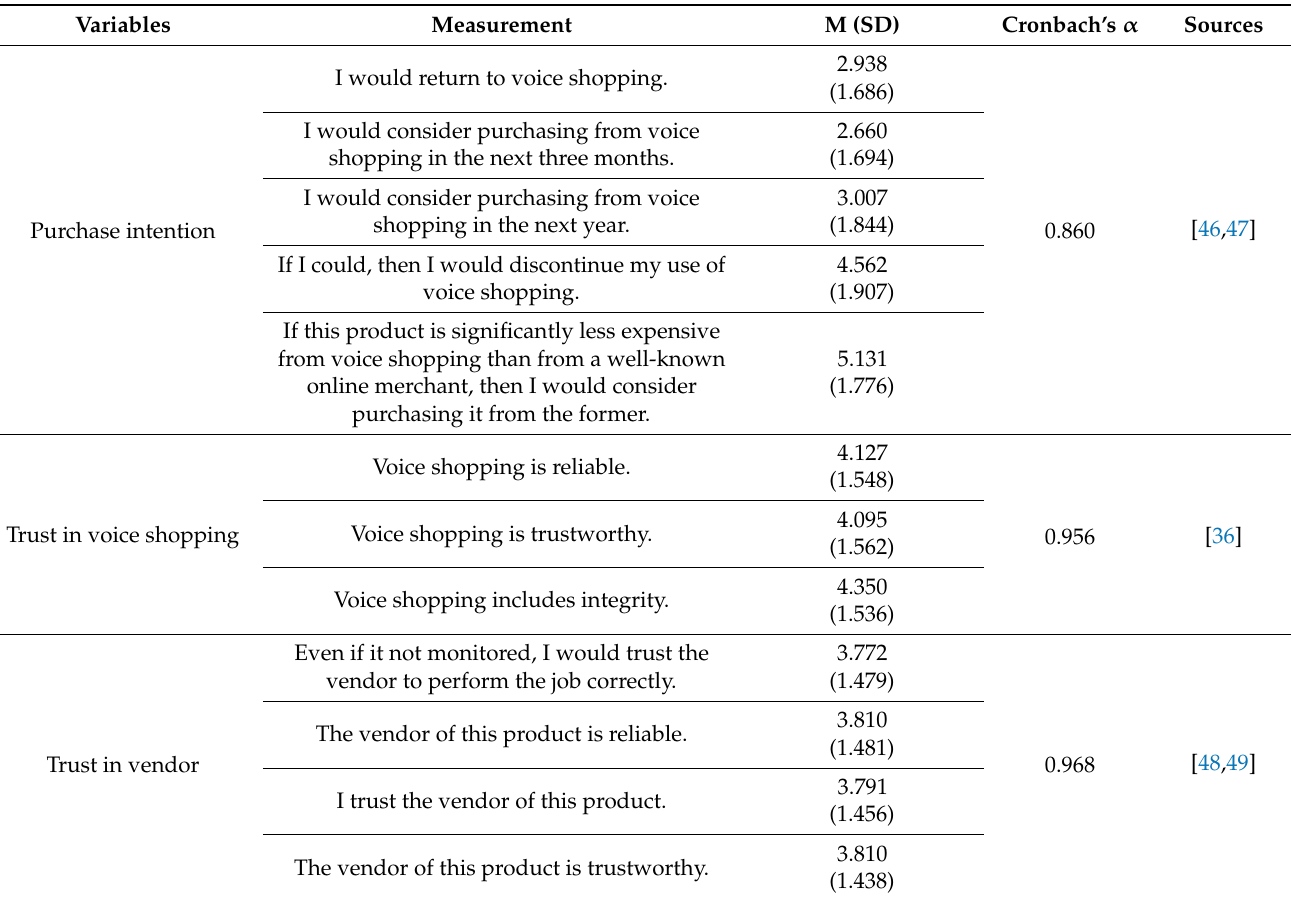
Table 1. The Dependent